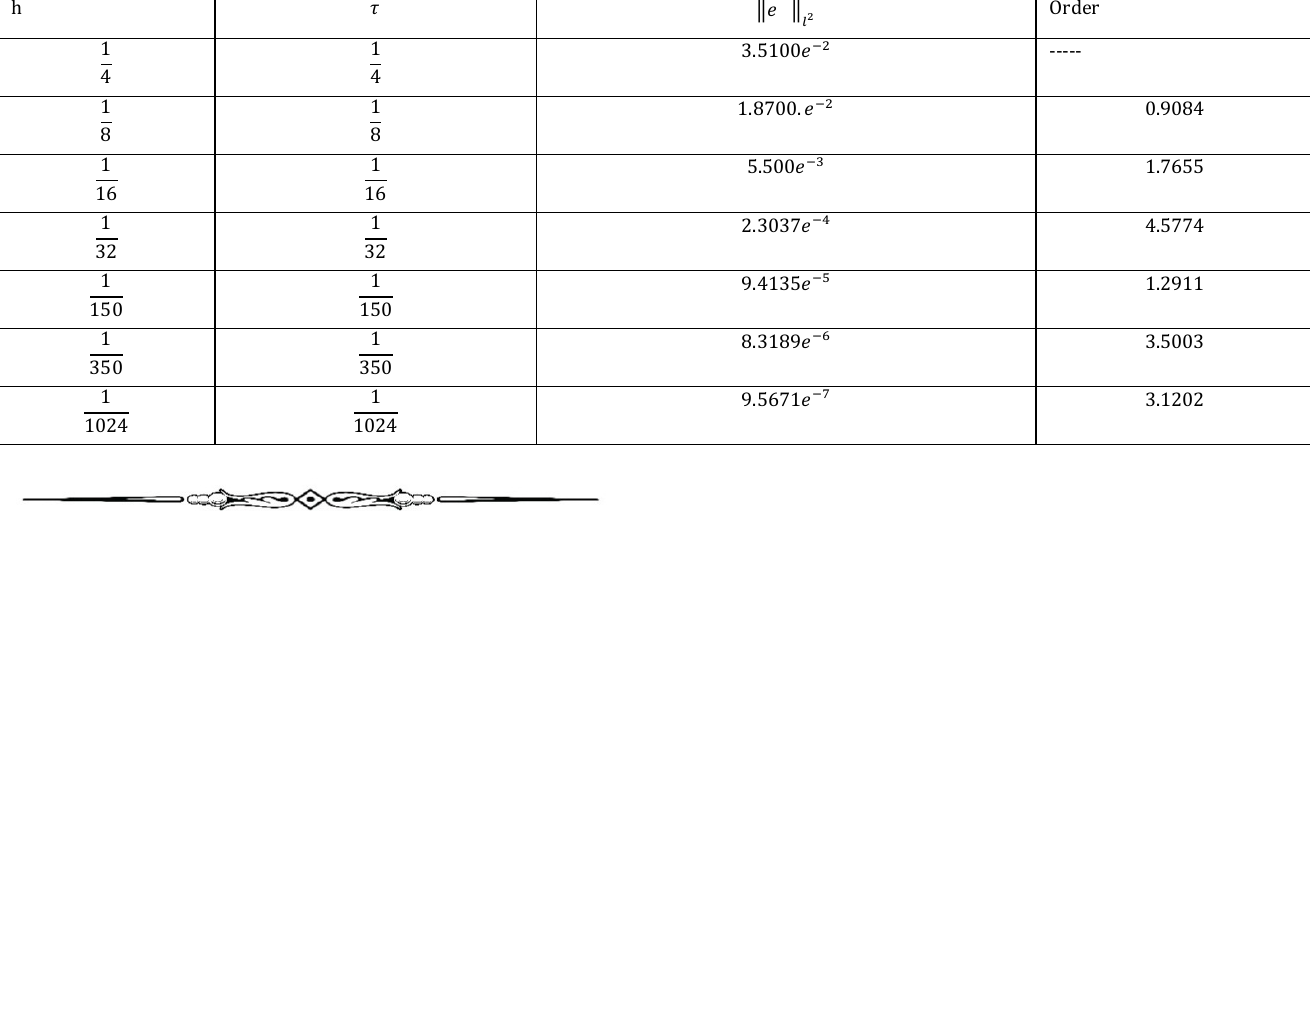
(Test Problem 3) Error norm, the accuracy order of the scheme for different value of 𝛾𝛾